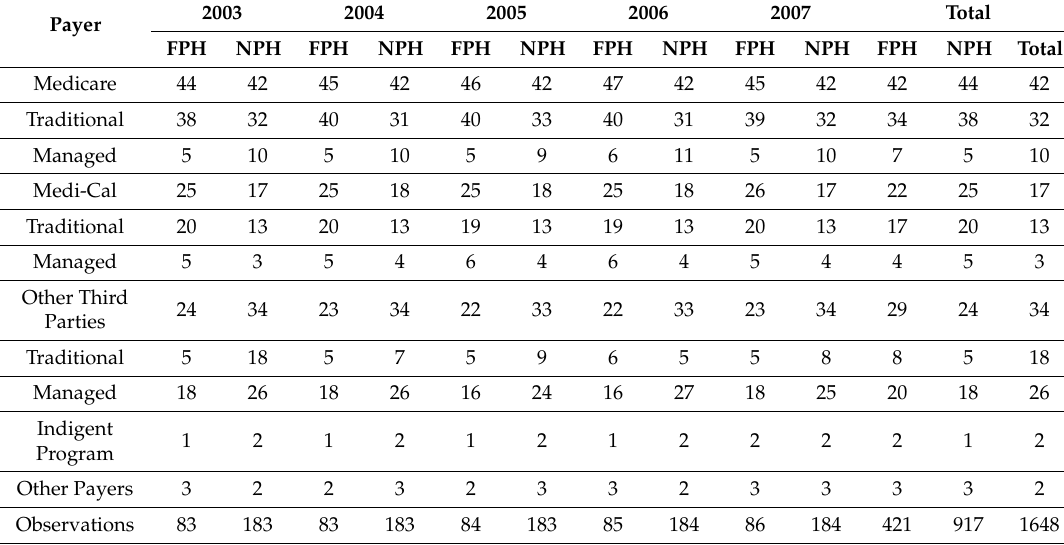
Table 6. Percentage of Inpatients by Payer